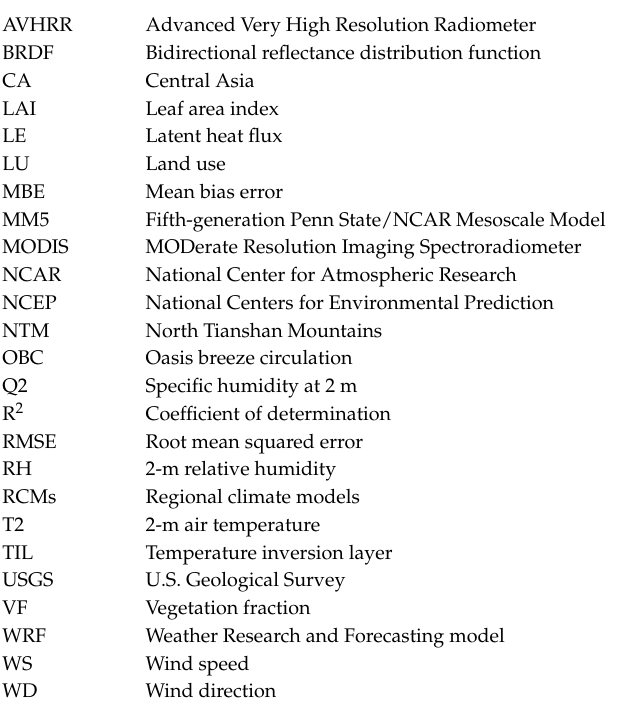
Table S1: Shows LU types and codes of for the 2012LU; Table S2: Land use type and its categories for WRF and the